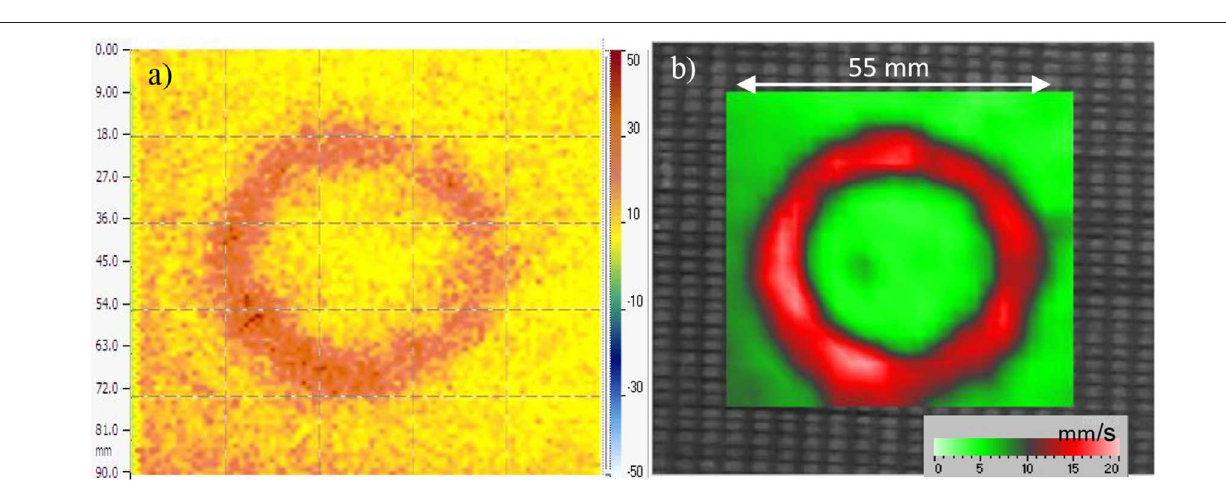
FIGURE 10 | (a) robotic scanning image of a ring delamination in CFRP; (b) wideband chirp laser vibrometry image.